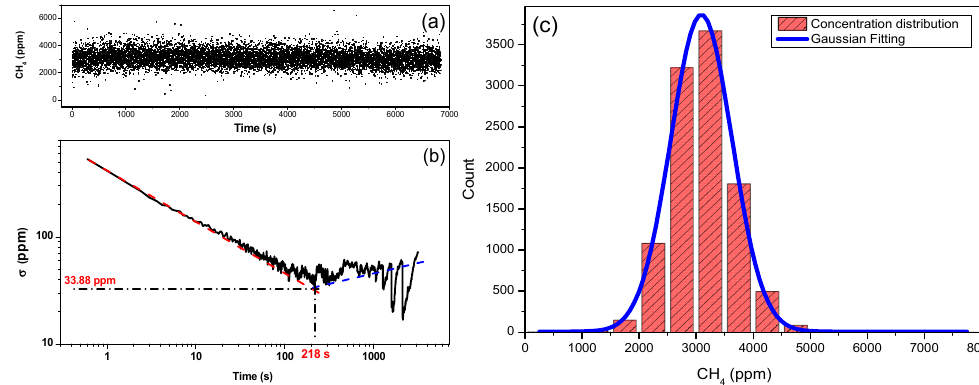
Figure 5. ( a ) Time series measurements of CH 4 concentration; ( b ) Allan deviation plot; ( c ) Histogram showing the distribution of the methane concentration retrieved from 10,540 absorption spectra recorded with 0.65 ‐ s integration time at ambient temperature and at a pressure of 42 mbar.